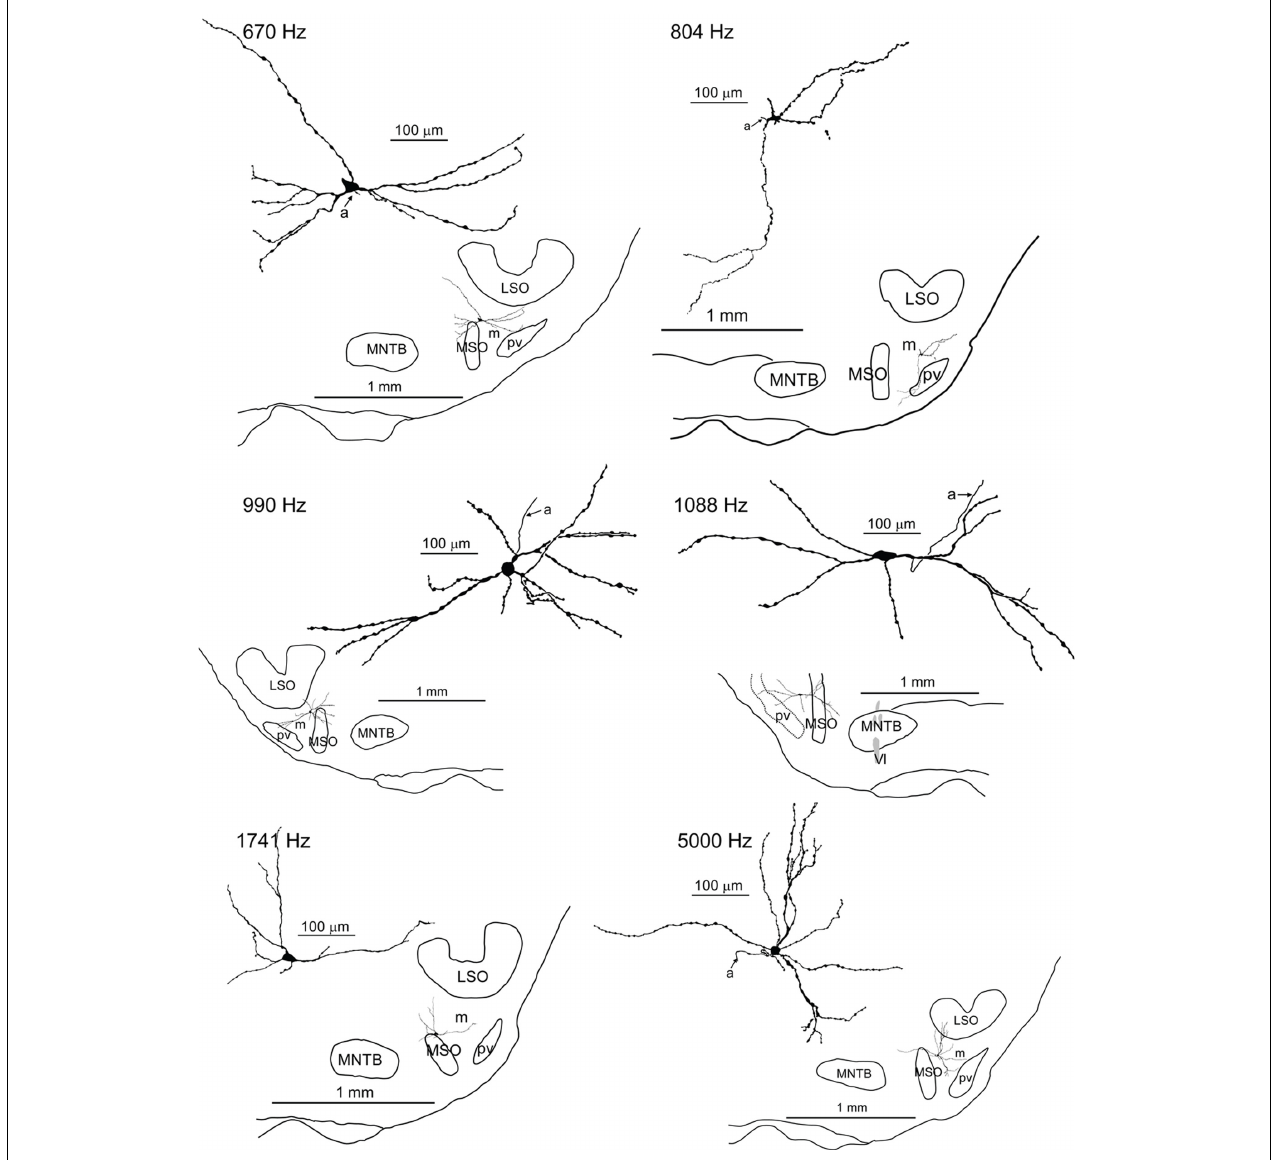
FIGURE 1 | Camera lucida drawings of six labeled neurons in the mLNTB. The CF is indicated for each neuron. Insets show the location of the labeled unit on a coronal brainstem section. a,